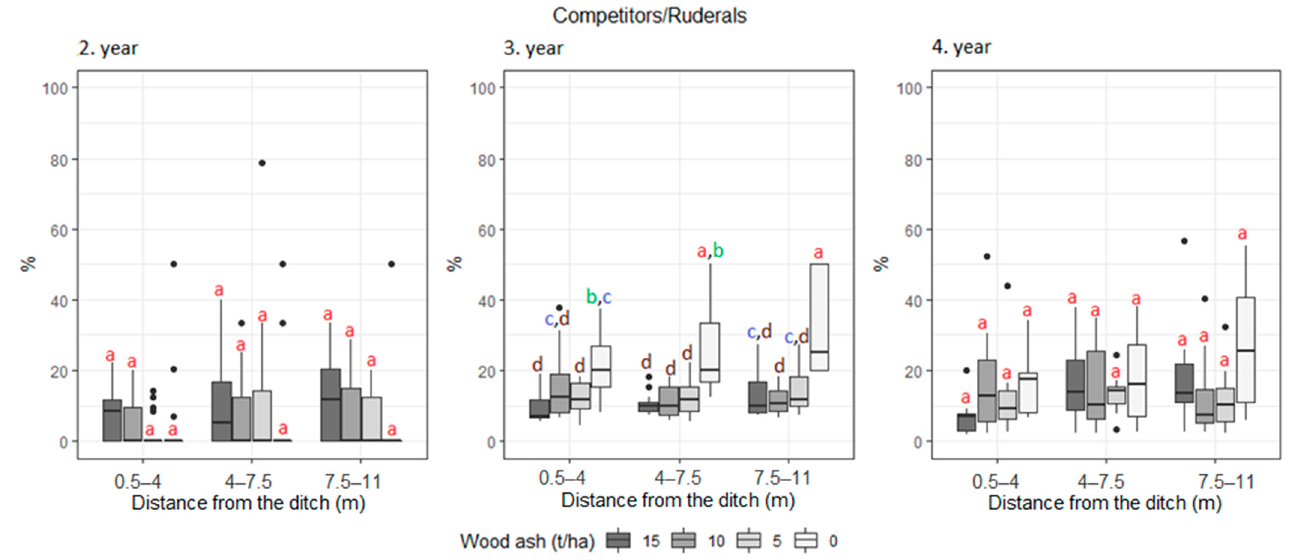
Figure A5. Relative cover of plants with competitor/ruderal universal adaptive strategy from the total vegetation cover, depending on the distance from the drainage ditch and the dose of wood-ash fertiliser. Different letters (a, b, c, d) indicate significant differences between groups, p < 0.05 according to the Tukey HSD test.